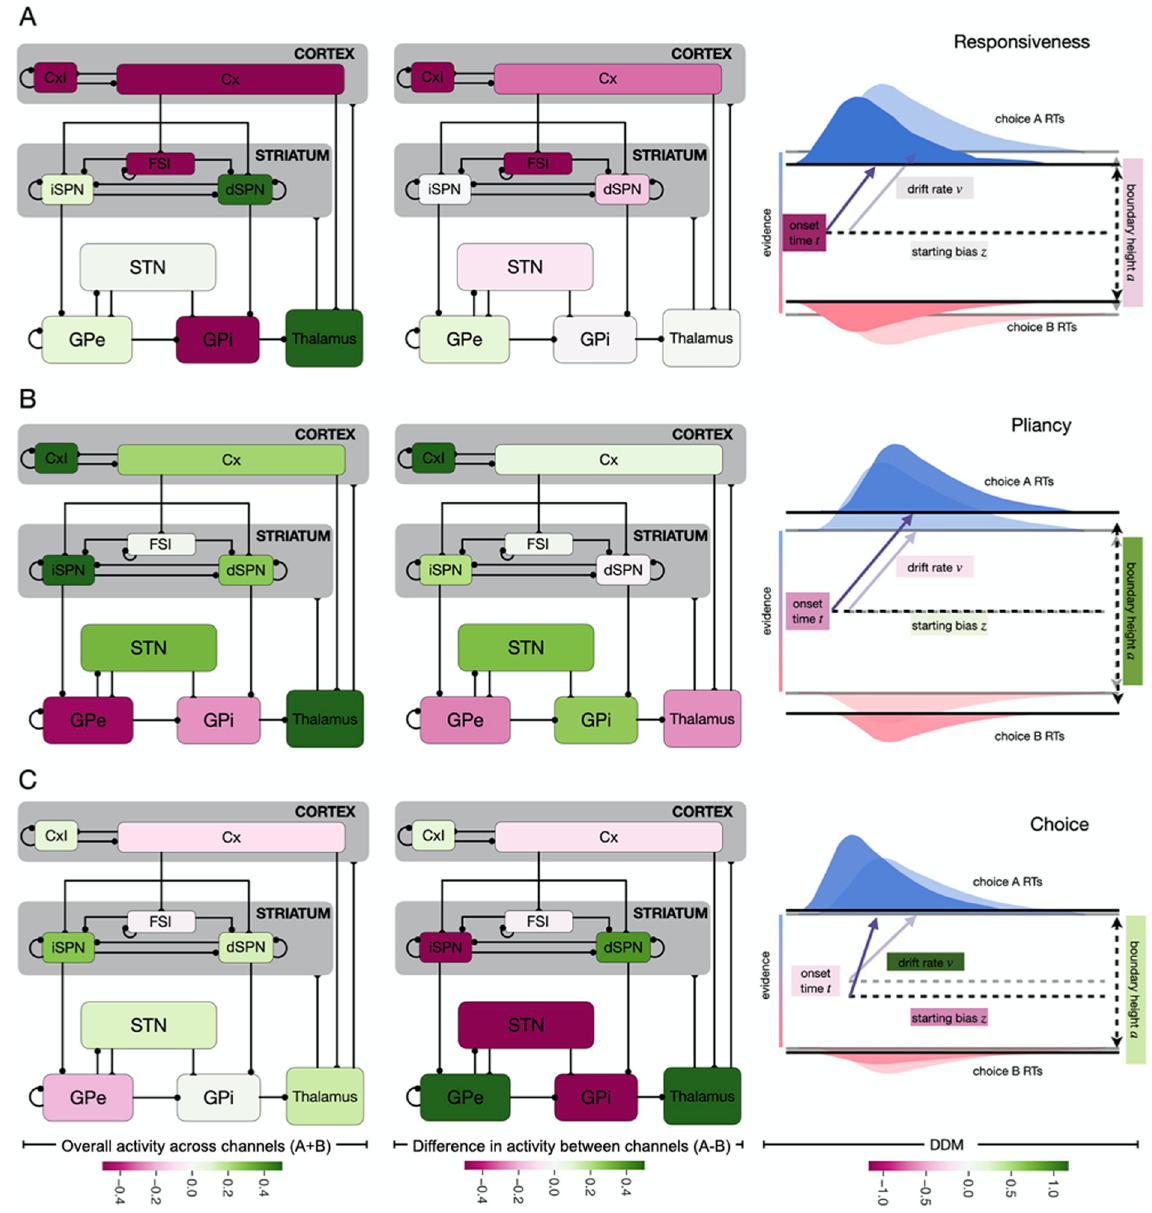
Fig 8. Canonical loadings obtained by applying the CCA to the mapping R ! P . Panels A, B, and C represent the relation between the firing rate of each population in the CBGT network and the parameters of the DDM obtained in the first, second and third components of the CCA, respectively. 1st column subpanels represent the overall activity summed across both channels while the 2nd column represents the differences in activity between the populations in the A and B channels. 3rd column subpanels depict the associated increases (green) and decreases (magenta) in the DDM